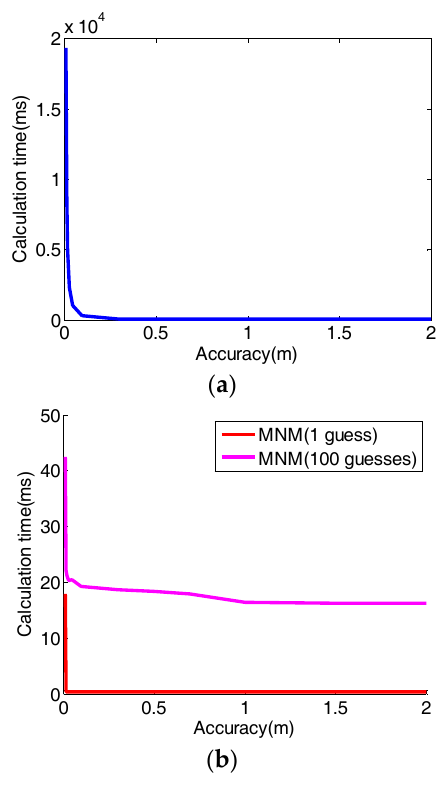
Figure 8. Computation time using different models: ( a ) Direct Search Model (DSM), ( b ) Modified Newton’s Method (MNM). Table 2. The calculation time (ms) using different methods ( k = 2.5, P = 96%, σ i = 1 m).